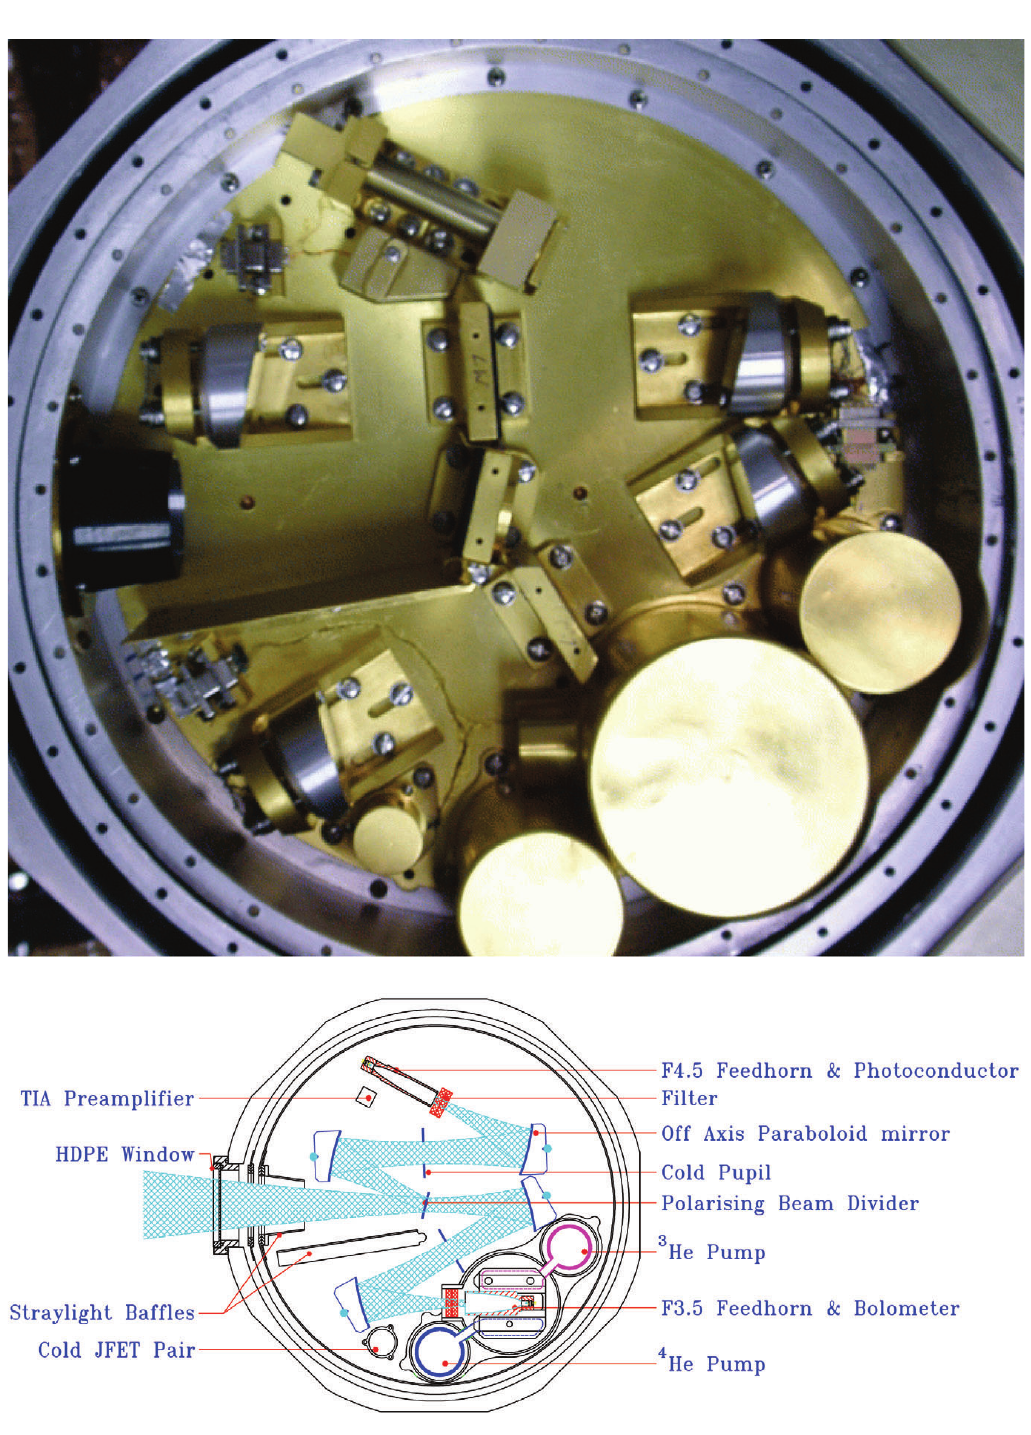
Fig. 8. The Cold Optics and Detector Module